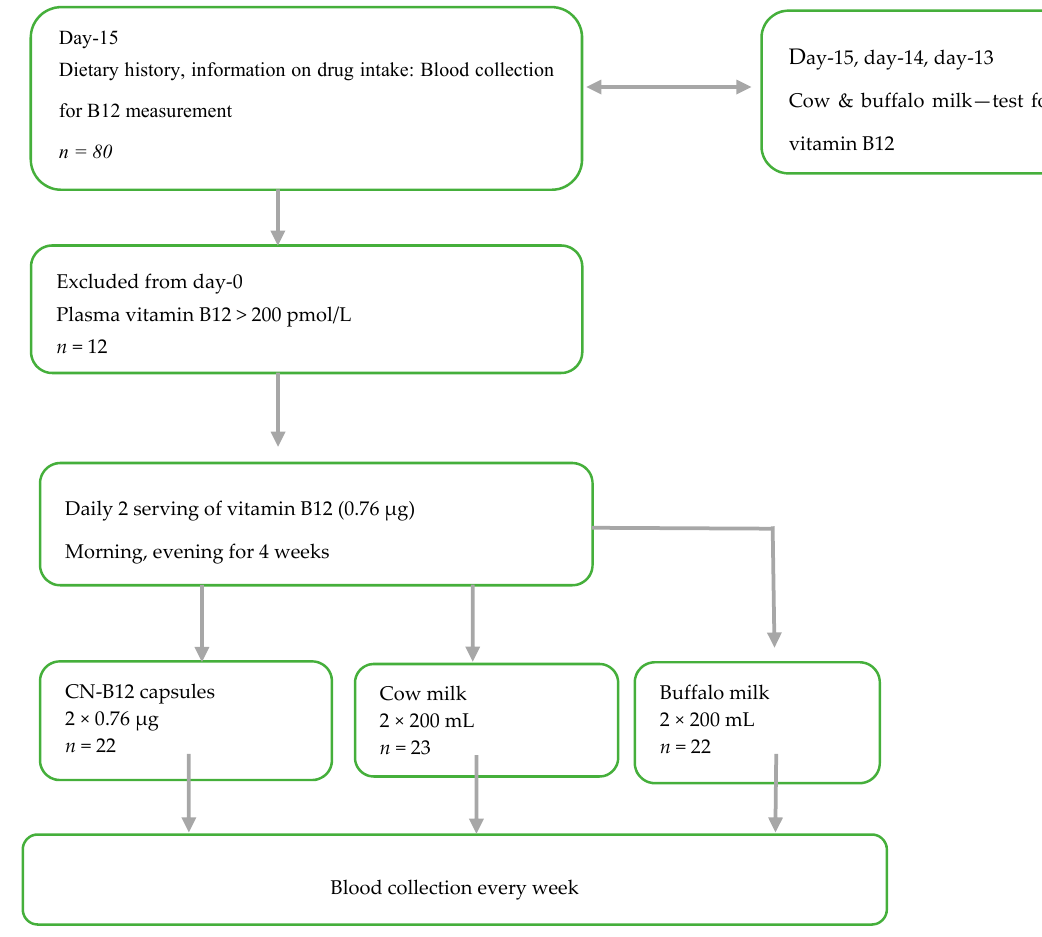
Figure 1. Scheme of the study.